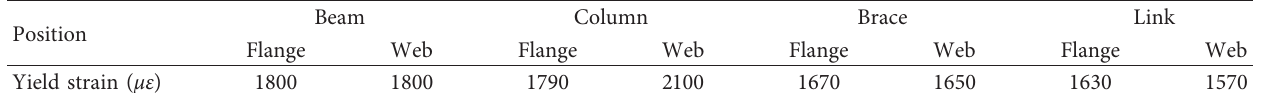
Table 4: Yield strain of each member.